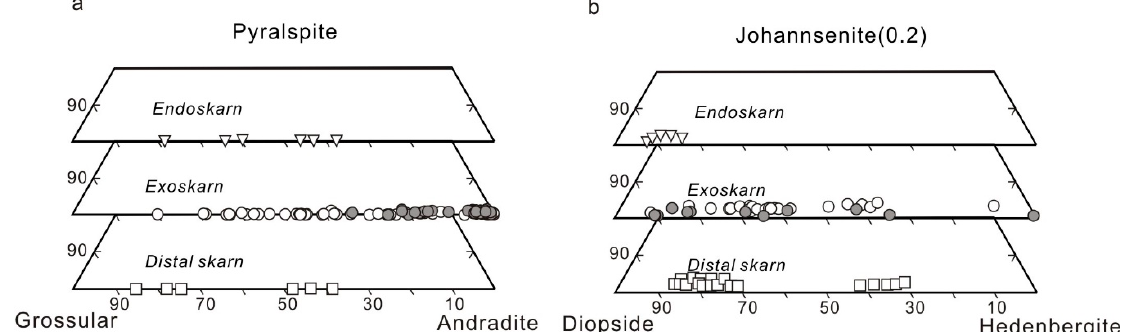
Figure 4. Major element compositions of garnets ( a ) and pyroxene ( b ) showing their dominance of end members from three selected skarn mineral deposits. Pyralspite–(pyrope + spessartine + almandine + uvarovite).